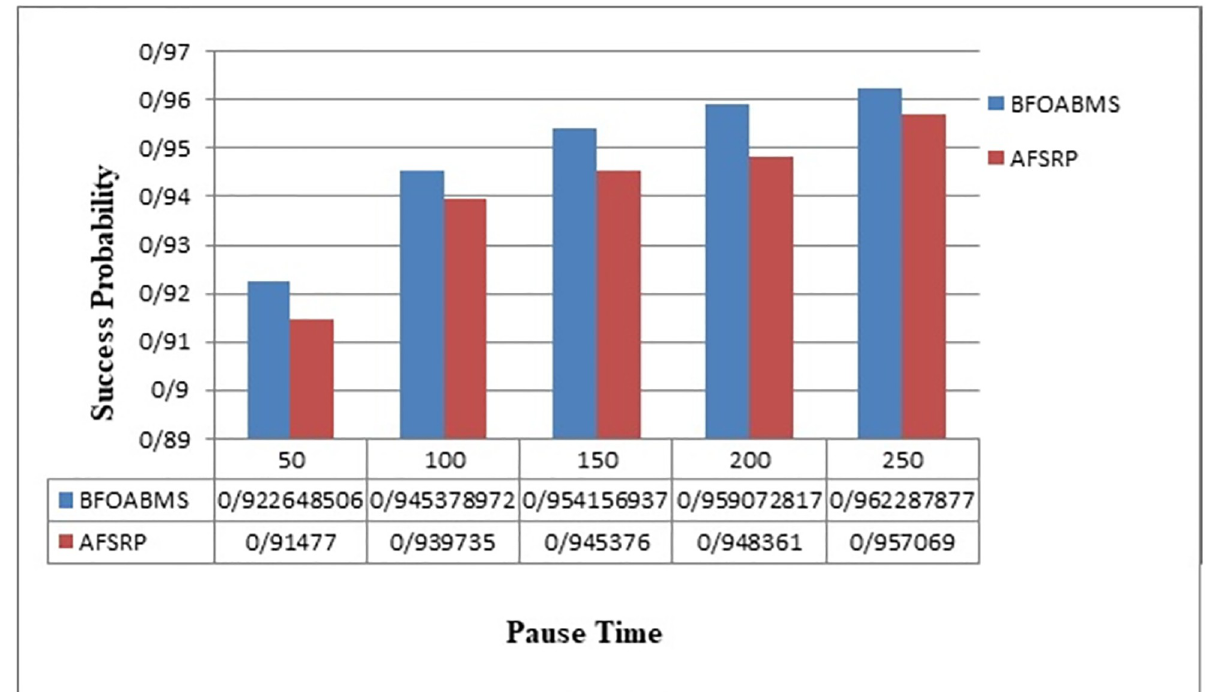
Fig 10. Delivery rate successfully closes data to the